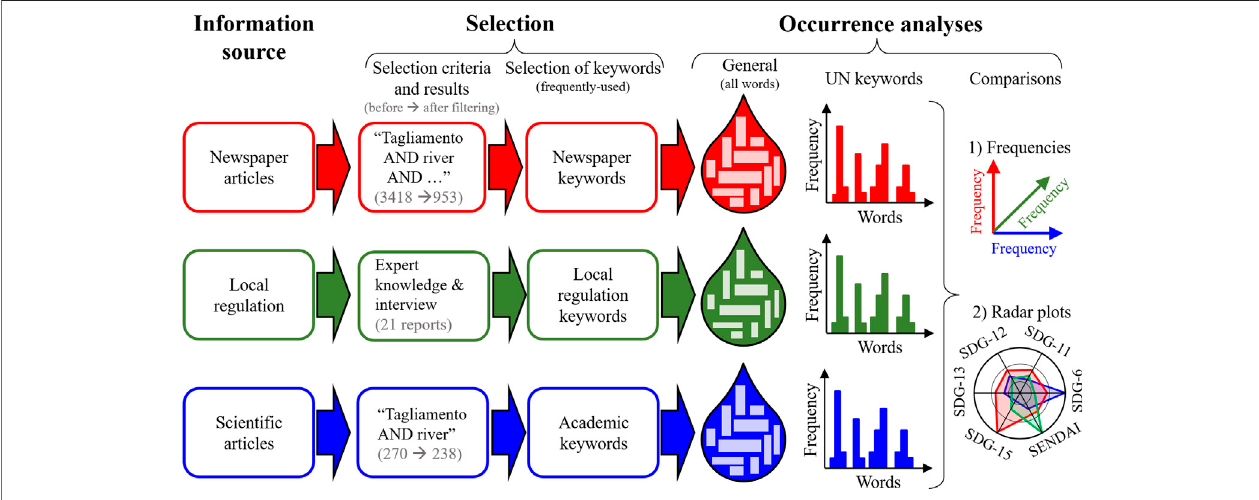
FIGURE1| Schematicshowingtheinformationsources,selectioncriteria,andoccurrenceanalyses leadingtocomparisons ofwordoccurrencesacrossthethree information sources.